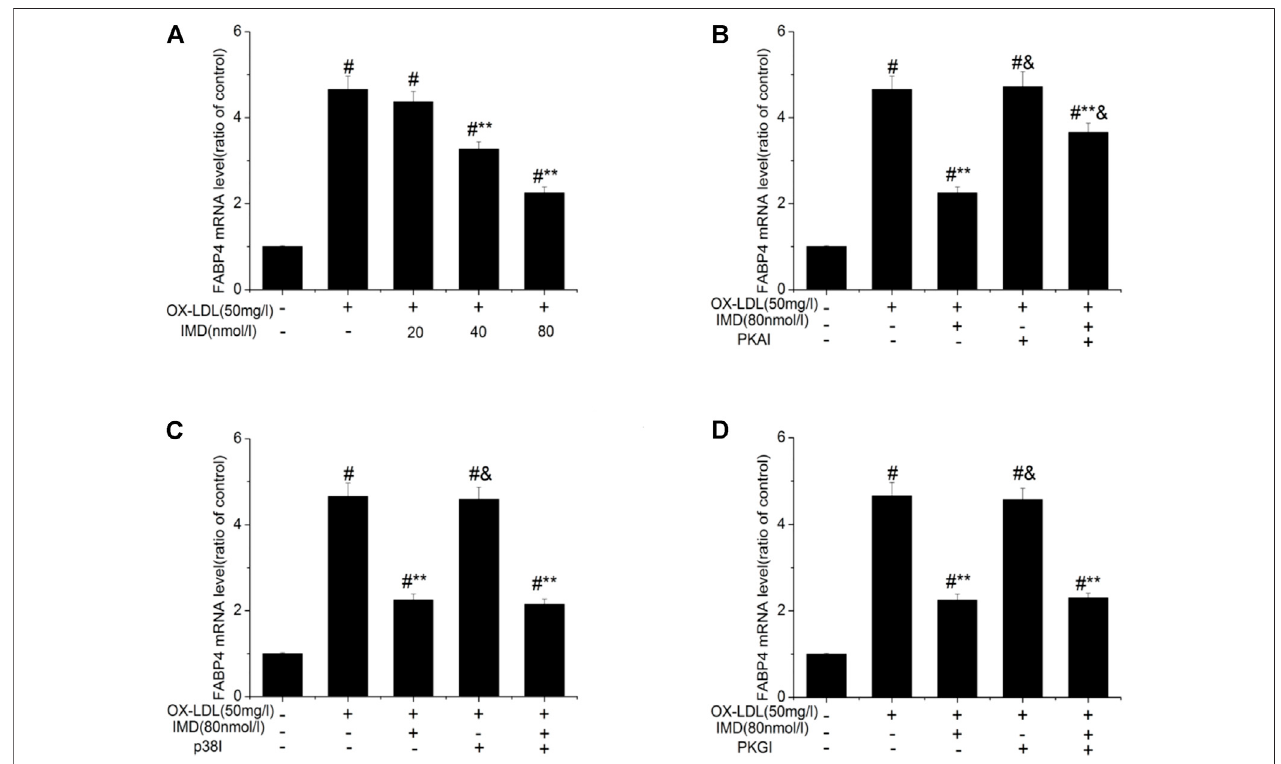
FIGURE 4 | IMD inhibits the mRNA expression of FABP4 in ox-LDL – induced macrophages. # Compared with the control group ( p < 0.05); ** compared to the ox- LDL alone group ( p < 0.05); & compared to the ox-LDL +IMD group ( p < 0.05).